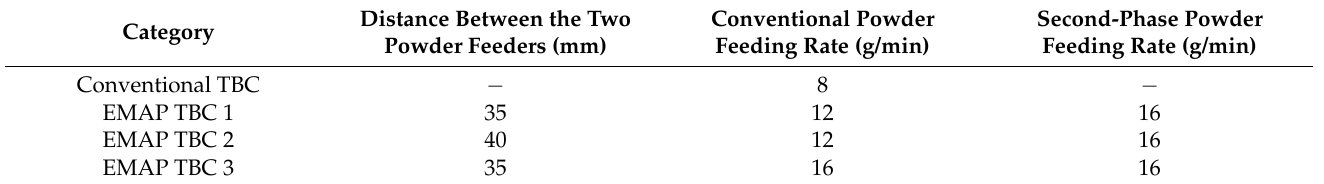
Figure 3. Schematic diagrams show the processes of controlling the microstructure of the EMAP TBC by adjusting the distance of the powder feeders. Table 1. Plasma spraying parameters for the deposition of conventional TBC and EMAP TBCs.